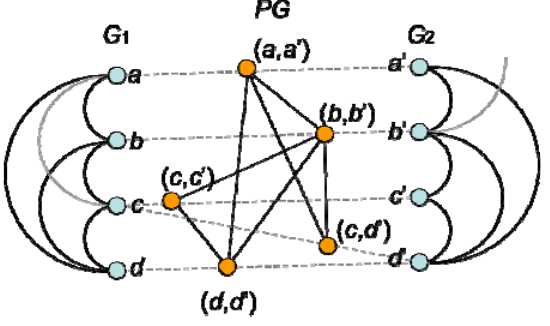
Figure 2. Product graph of two